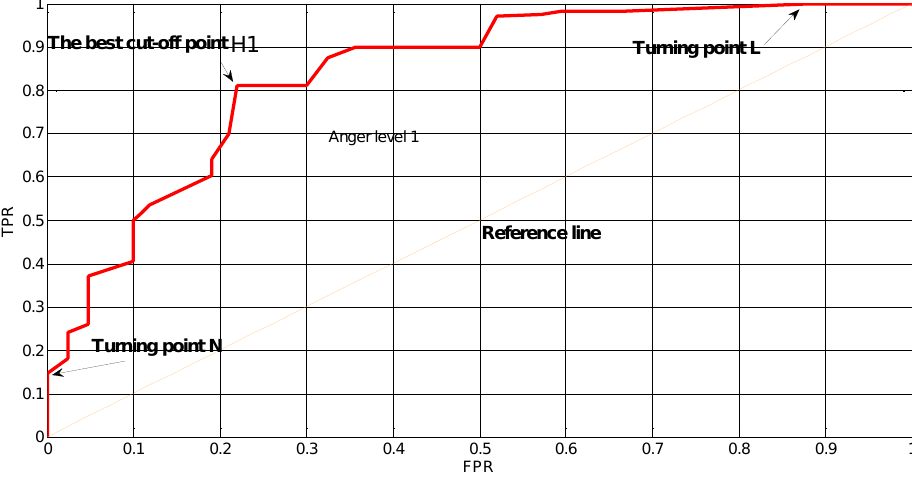
Figure 7. The ROC curve of β% at anger level 1.